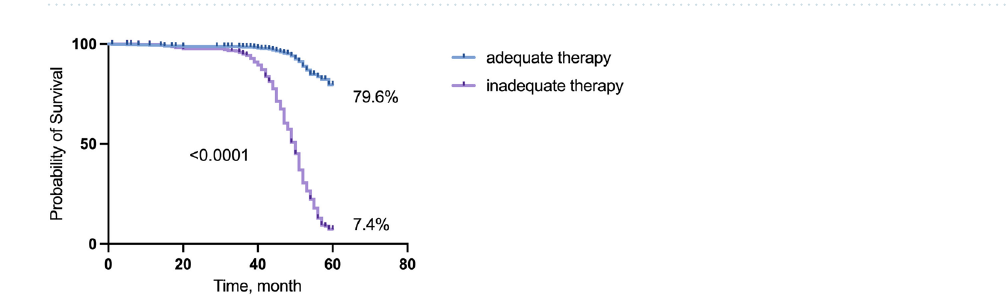
Figure 7. Metastatic-free survival of breast cancer patients treated according to molecular subtype of the primary